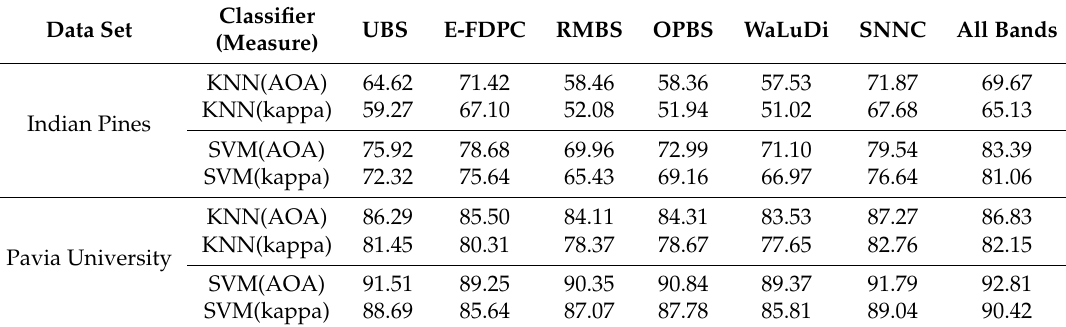
Table 1. AOA and kappa on two data sets for different band selection methods. Data